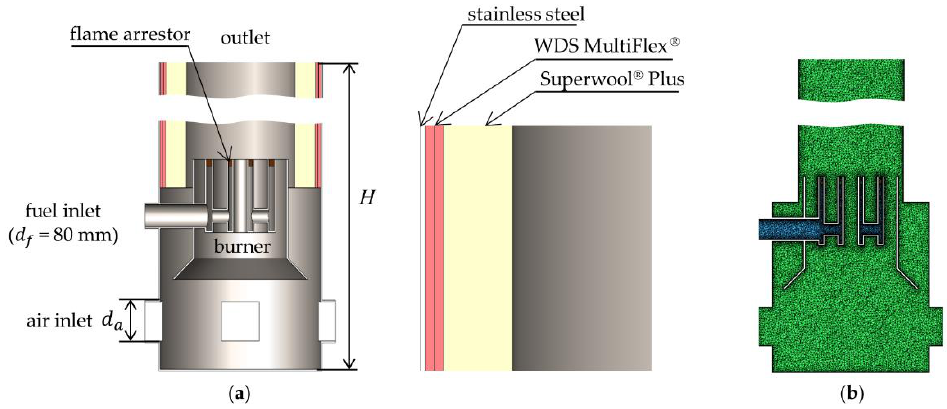
Table 1. Combustor parameters.